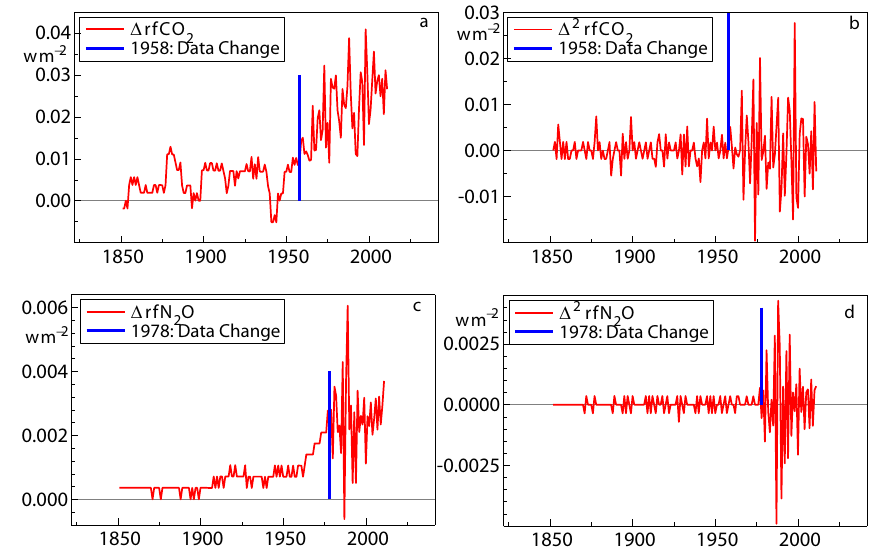
Fig. 2. Time series of the first and second differences of rfCO 2 and rfN 2